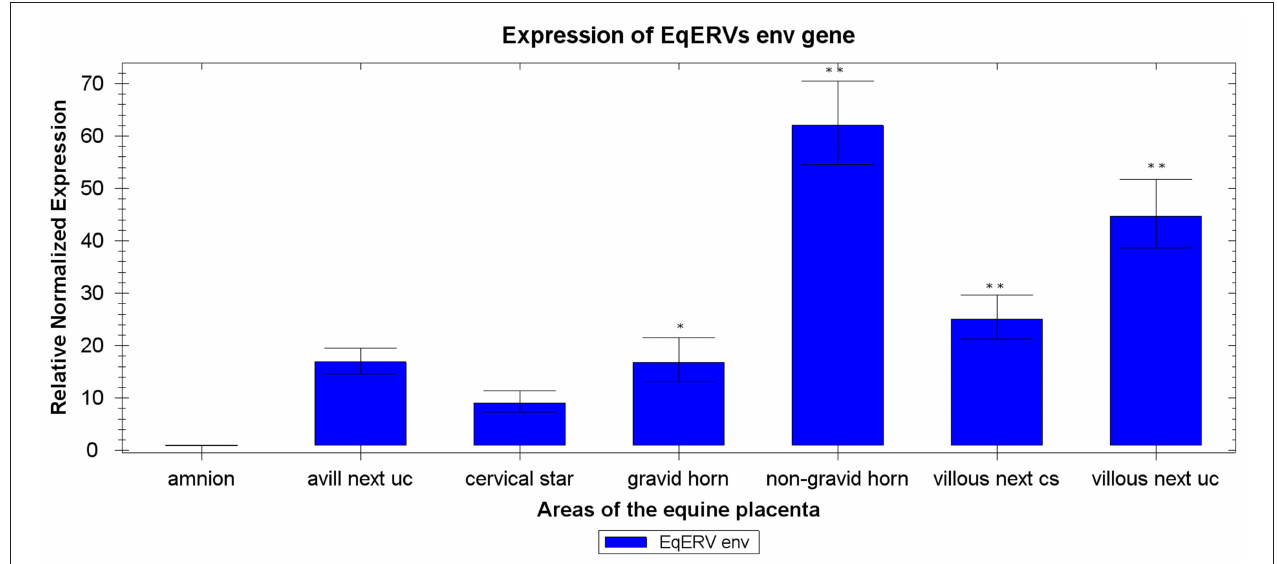
FIGURE 2 | Expression of EqERVs env RNAs in various areas of the equine placenta detected with RT-qPCR. Each value was normalized to the levels of two reference genes ( ACTB and RPL32 ) and is shown as the mean of triplicate experiments. The x -axis shows the different areas of the equine placenta, and the y -axis shows the relative normalized expression, with the standard error. Technical replicates were averaged and only those samples with a standard error lower than 0.2 Cq were retained. **indicates p < 0.001 and *indicates p < 0.05 with respect to amnion, as shown by ANOVA. Uc, umbilical cord attachment; cs, cervical